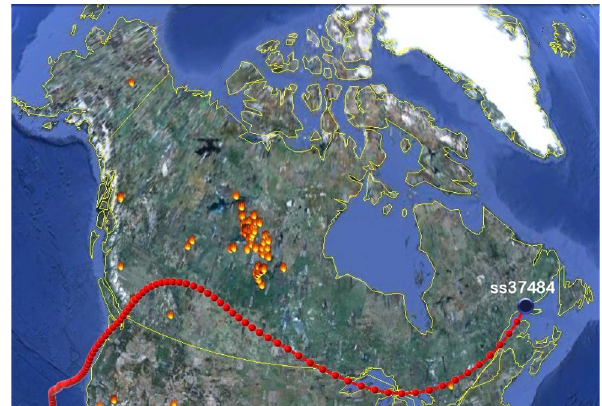
Fig. 1. A sample output of the trajectory data obtained using HYSPLIT. The 3-day back trajectory calculated from occultation ss37484 measured on 29 July 2010 is displayed in Google™ Earth with the instances of fire activity observed by MODIS over Canada on 27 July 2010. Spatial and temporal coincidences of the trajec- tory confirm that the emission source of the ACE-FTS measure- ment of enhanced HCN to be the widespread Boreal fires in north- ern Saskatchewan and parts of the Northwest